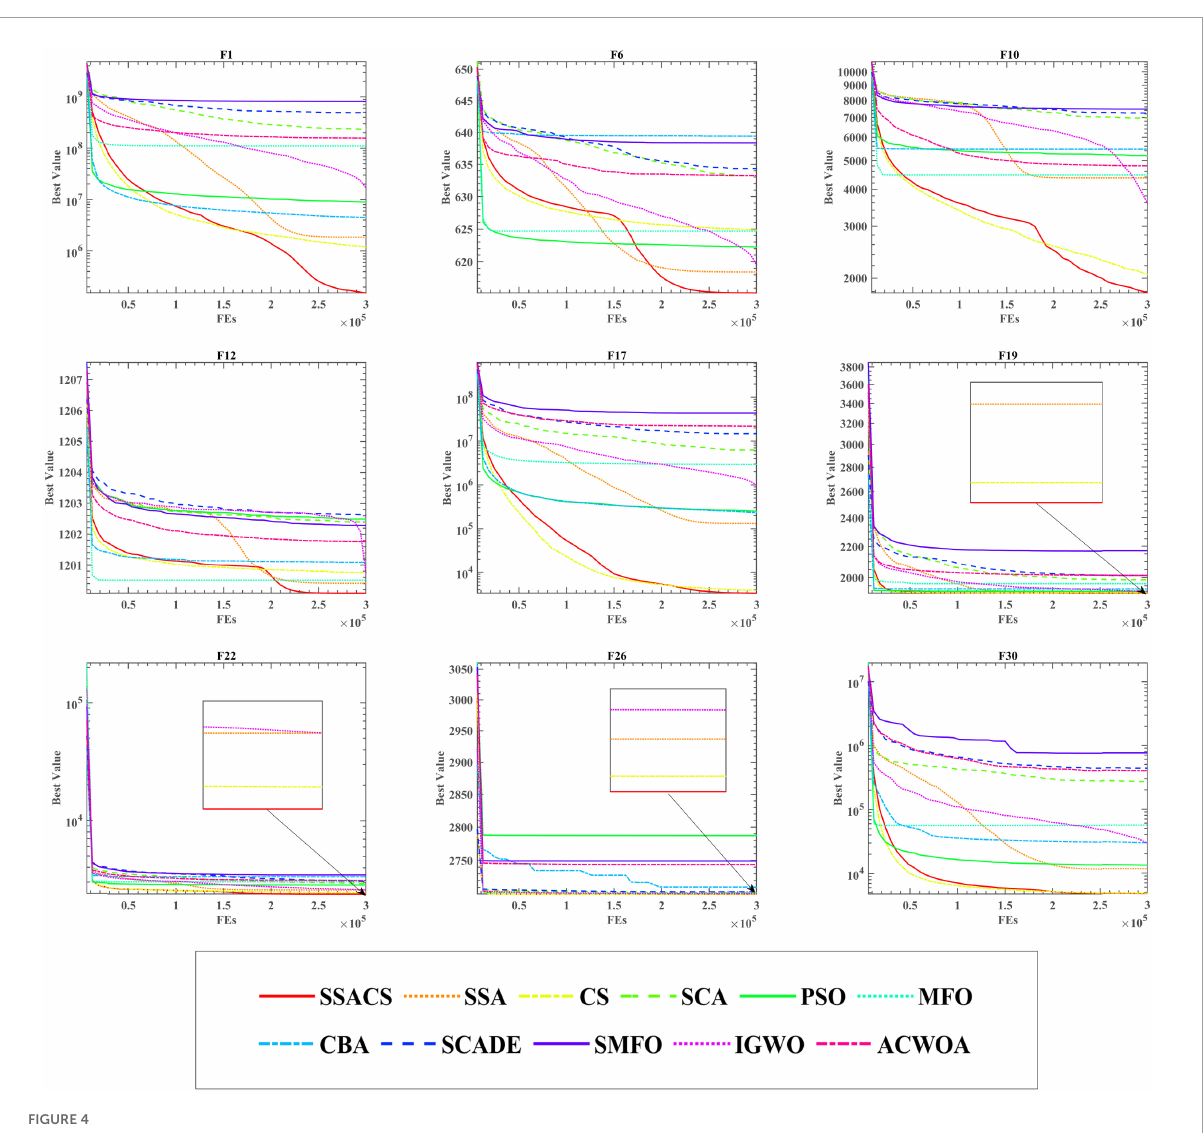
FIGURE4 Convergence curves of SSACS and